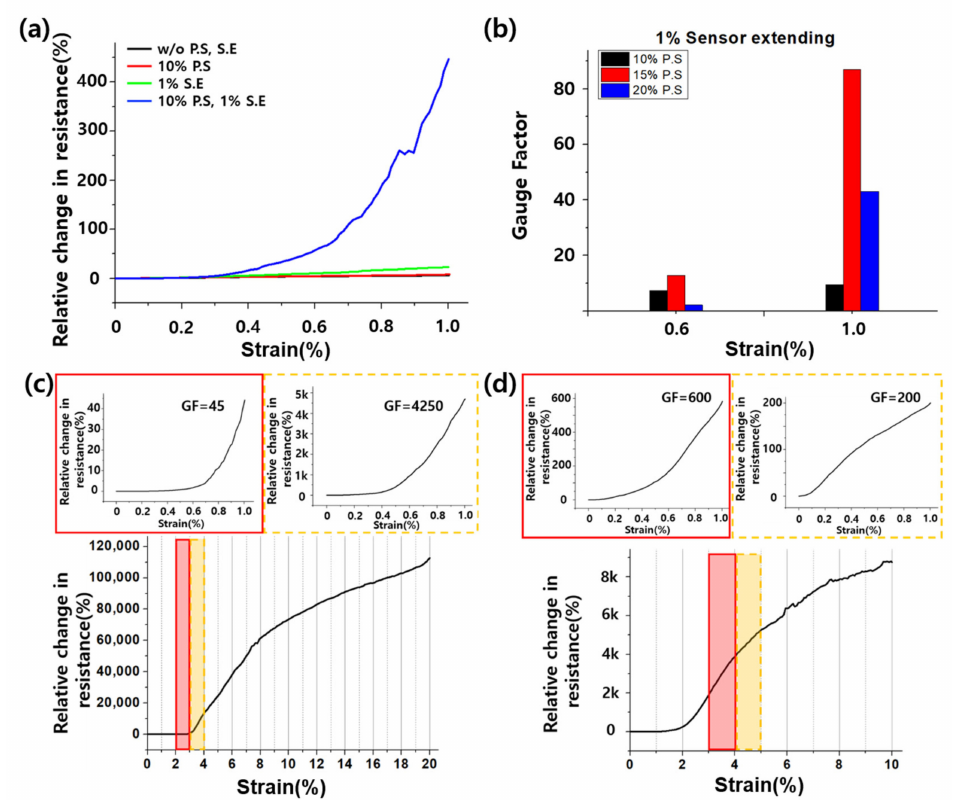
Figure 4. ( a ) Relative resistance change of the four sensor types under 1% strain. ( b ) Gauge factor at 0.6% and 1% strain according to the pre-strain percentage under 1% sensor extension. ( c ) Relative resistance change under 20% strain: red line box, pre-strain 20% and sensor-extending 2% under 1% strain; orange dotted line box, pre-strain 20% and sensor-extending 3% under 1% strain. ( d ) Relative resistance change under 10% strain: red line box, pre-strain 10% and sensor-extending 2% under 1% strain; orange dotted line box, pre-strain 10% and sensor-extending 3% under 1%